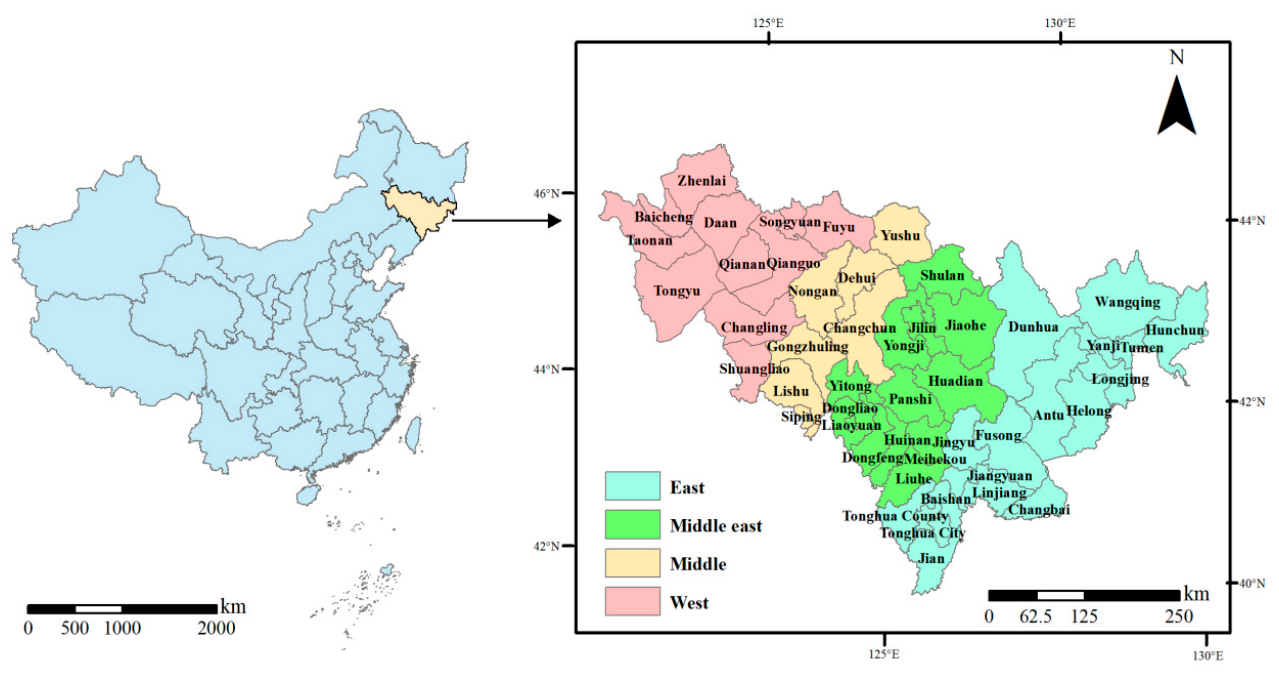
Figure 1. Location of Jilin province and its counties. Table 1. General characteristics of different regions in Jilin Province. Region